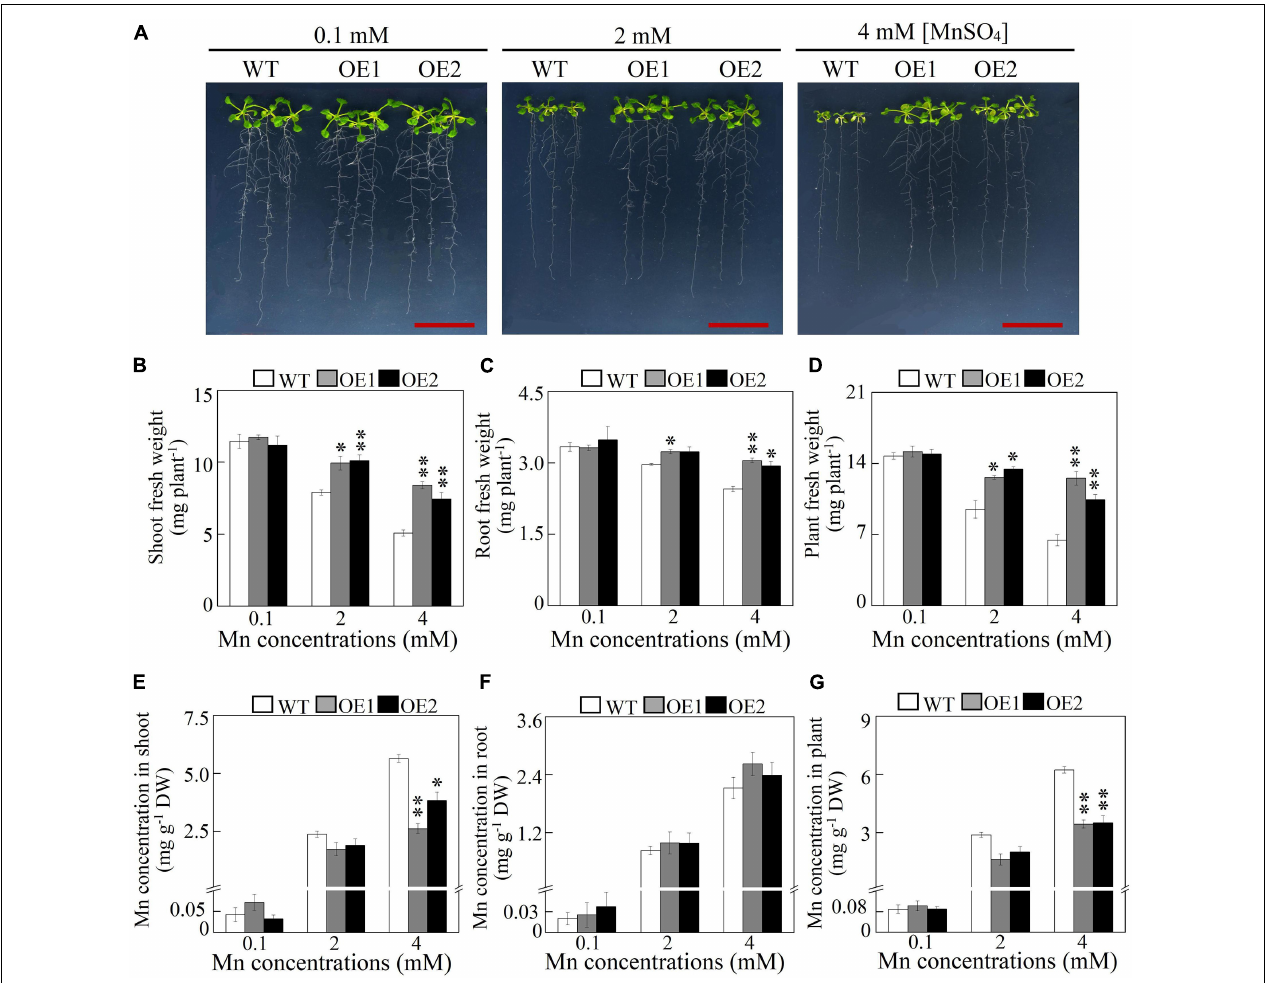
FIGURE 8 | Growth and Mn concentration of Arabidopsis overexpressing GmMTP8.1 . (A) Phenotype of Arabidopsis grown with different Mn treatments. (B) Shoot fresh weight. (C) Root fresh weight. (D) Plant fresh weight. (E) Mn concentration in shoot. (F) Mn concentration in root. (G) Mn concentration in plant. Seven-day-old Arabidopsis seedlings were transferred to a solid Murashige and Skoog (MS) medium containing 0.1, 2, or 4 mM MnSO 4 . Arabidopsis plants treated with 0.1 mM MnSO 4 were set as the control. After 7 days of Mn treatment, fresh weight and Mn concentration were determined. WT represents the wild type Arabidopsis. OE1 and OE2 are two transgenic lines overexpressing GmMTP8.1 . Each bar represents the mean value of three independent replicates with standard error. White, gray, and black bars represent WT, OE1, and OE2, respectively. Asterisks indicate significant differences between the wild type and the overexpression lines with the same Mn treatment. *, 0.01 < P < 0.05. **, 0.001 < P < 0.01. DW, dry weight. Scale bar is 2